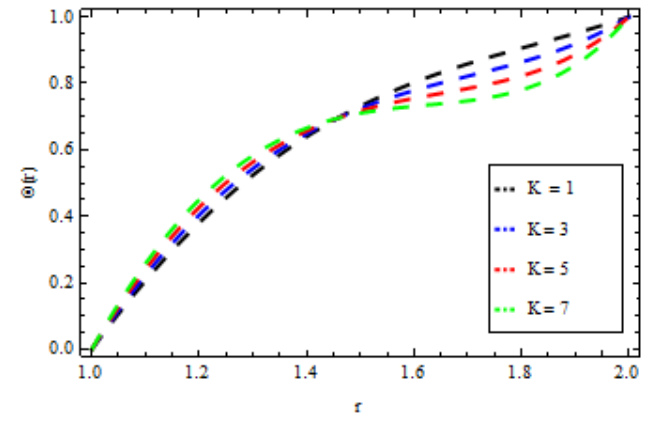
Figure 10. Temperature profile for various values of K when δ = 2, β = 0.2, M = 0.2, Br =